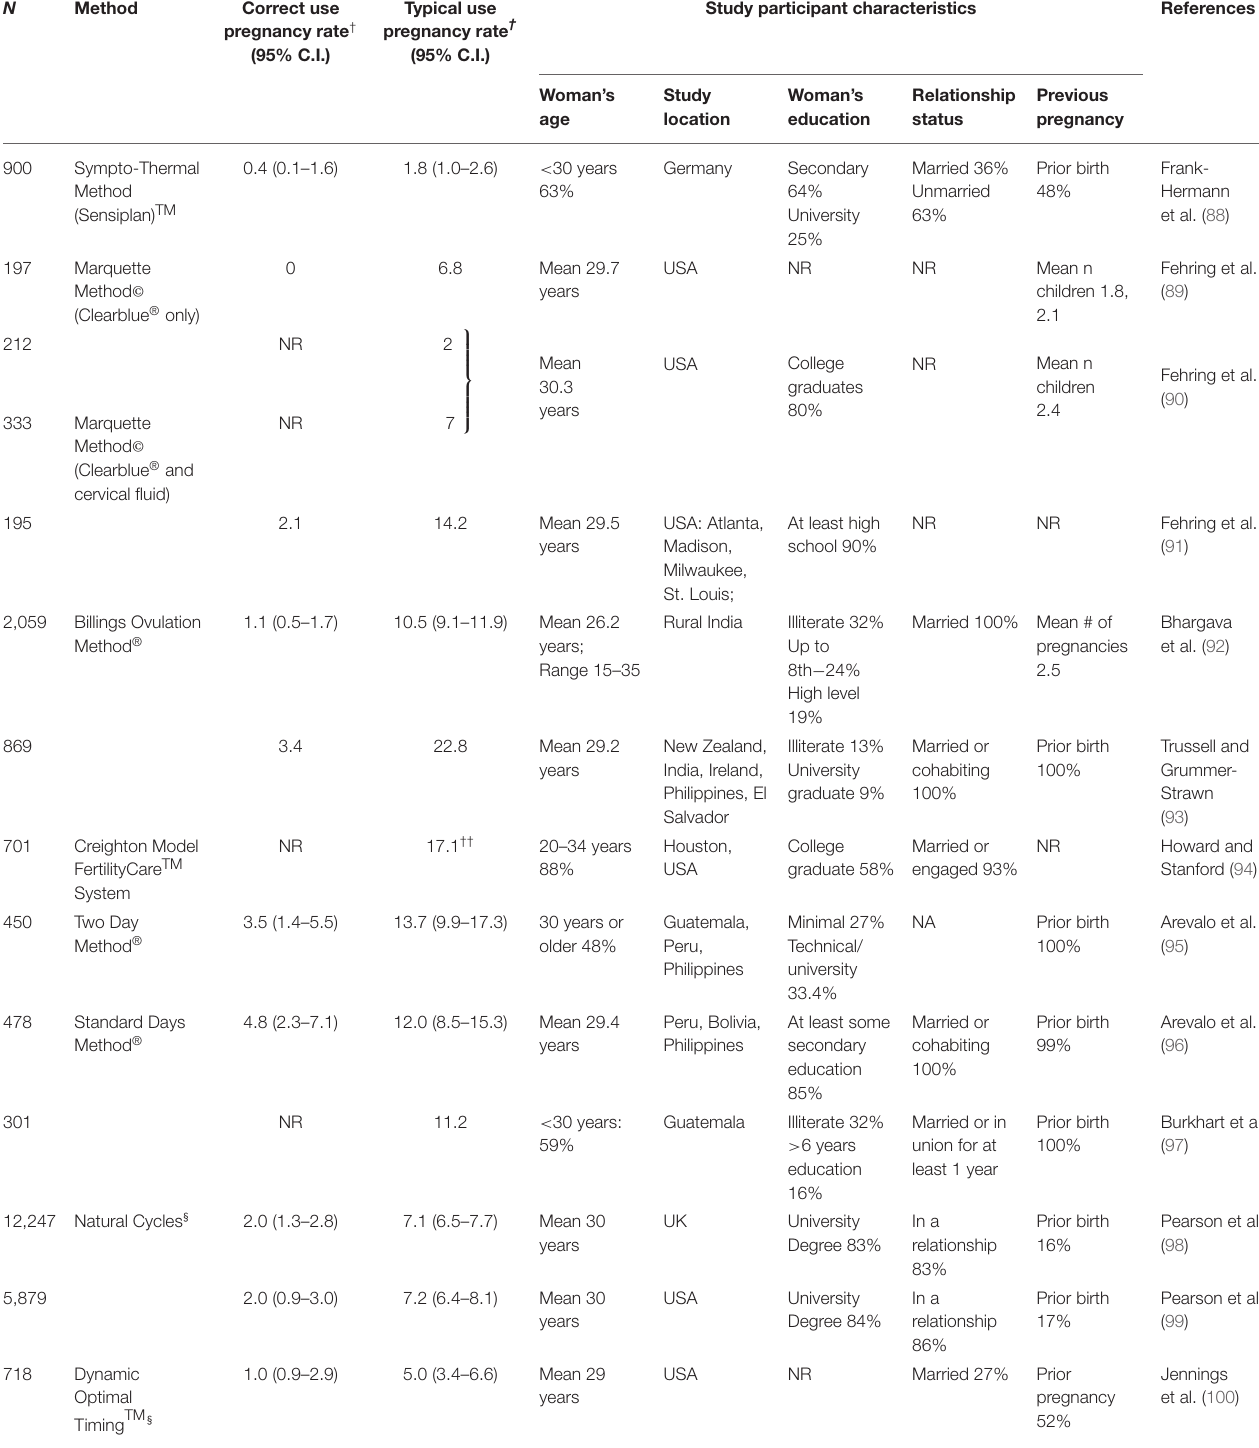
TABLE 6 | Pregnancy rates for fertility awareness-based methods used to avoid